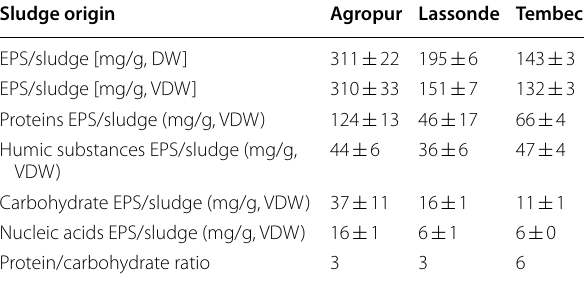
Table 4 Compound classes of EPS extracted Sludge origin Agropur Lassonde